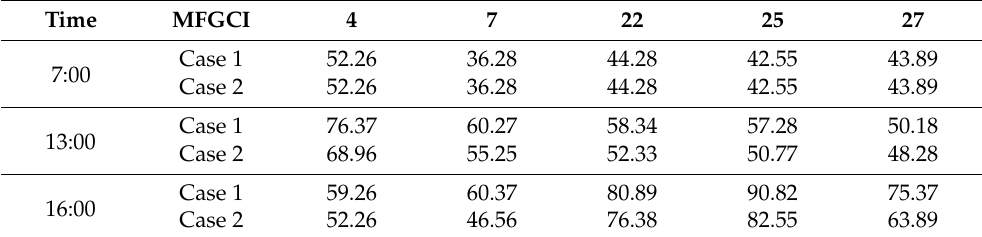
Table 13. Comparison of active power reduction by MFGCI